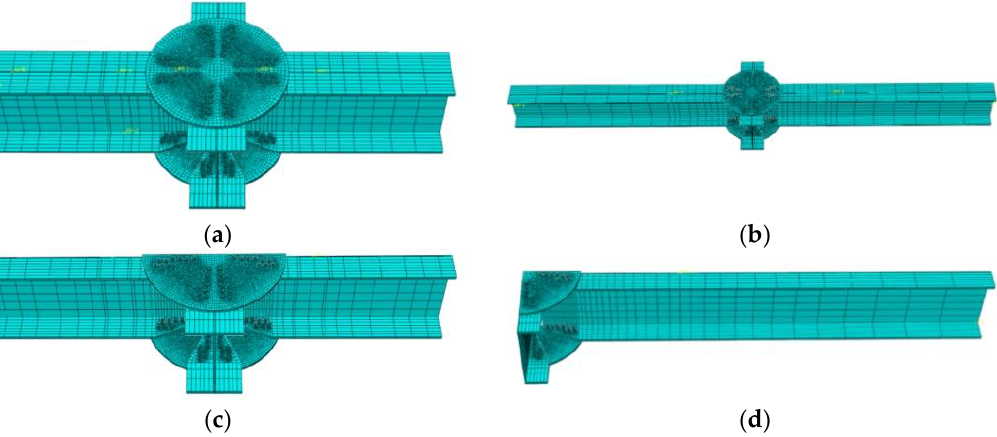
Figure 4. FE models. ( a ) Diagram of full model of Q series; ( b ) diagram of full model of M series; ( c ) diagram of semi-model of Q series; ( d ) diagram of quarter model of M